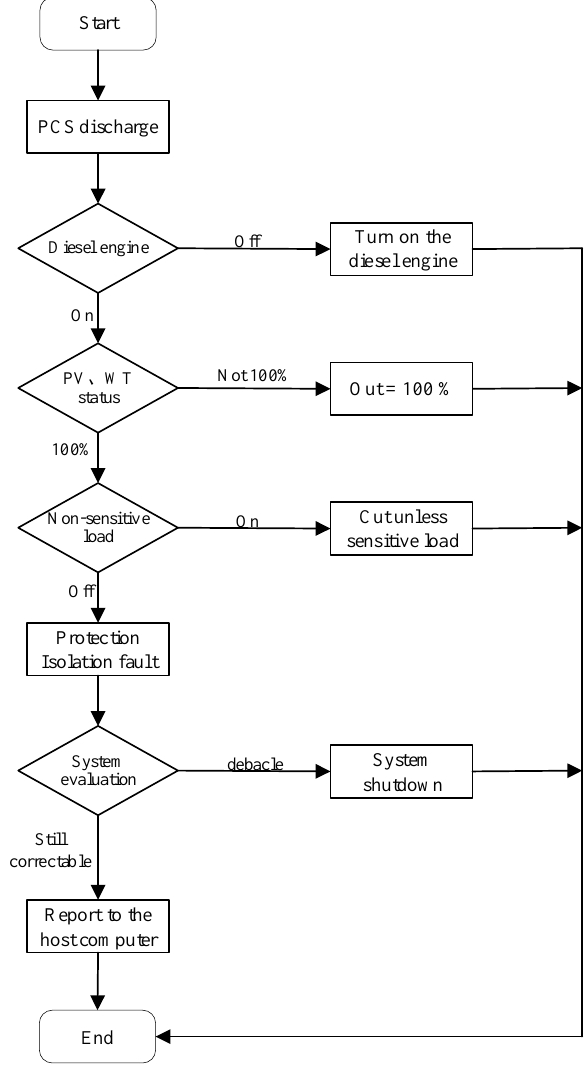
Figure 5. CL zone frequency control strategy.